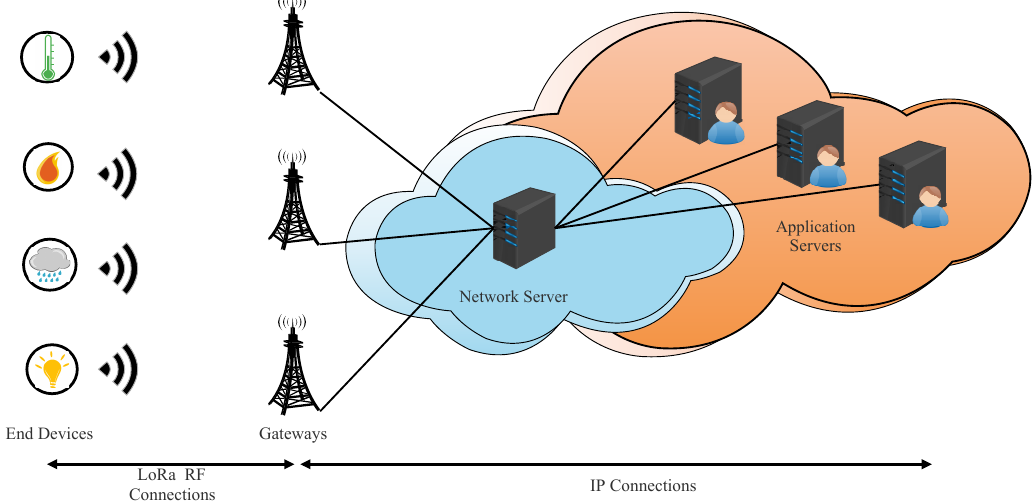
Figure 1. LoRaWAN v1.0